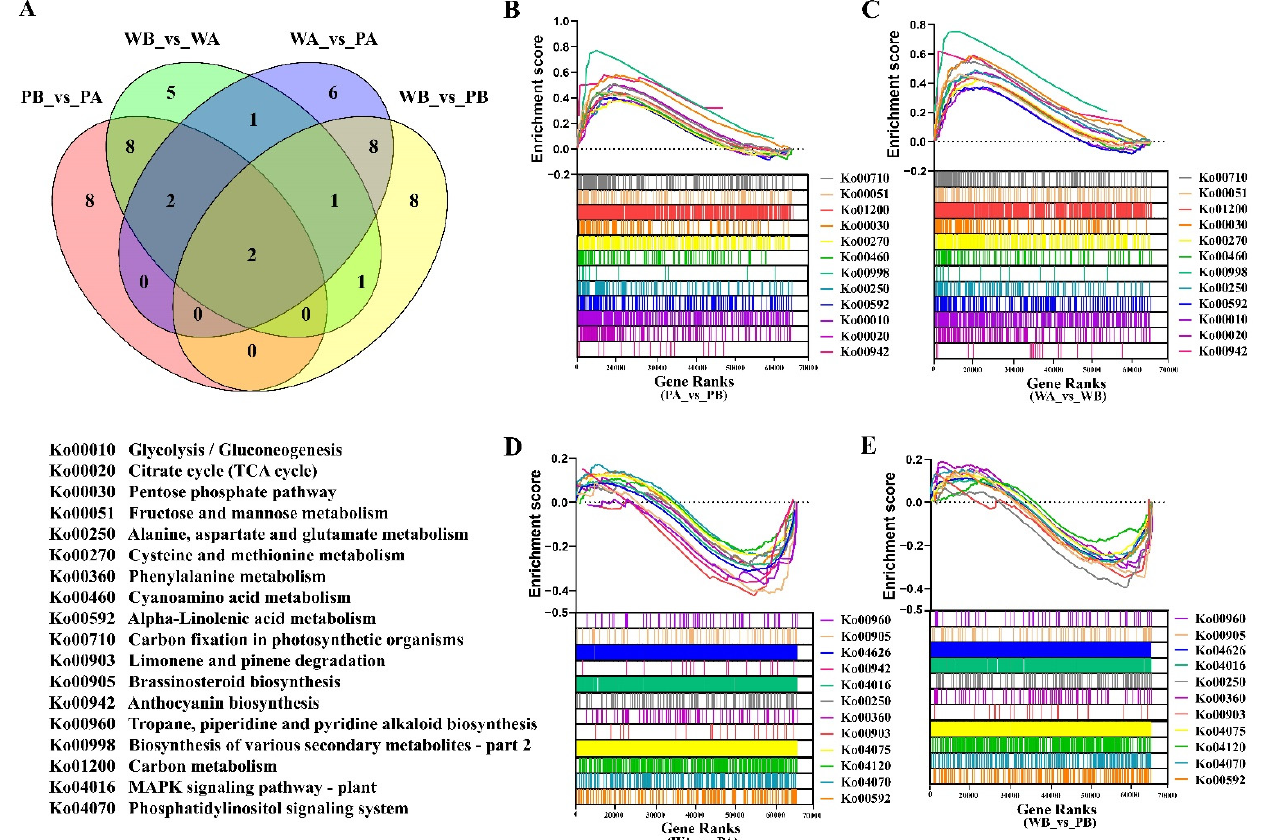
Figure 5. Gene set enrichment analysis (GSEA) was performed in four different comparison groups. ( A ) Venn diagram shows the distribution of the top20 enriched gene sets from four comparison groups (PA_vs_PB, WA_vs_WB, WA_vs_PA, and WB_vs_PB). ( B , C ) Represents the overlapping enriched gene sets from GSEA, comparing spot with non-spot of petals of PF or X74 (PA_vs_PB and WA_vs_WB). ( D , E ) Represents the overlapping enriched gene sets from GSEA comparing PF petals colored with X74 petals colorless regions of spot or non-spot. (WA_vs_PA and WB_vs_PB). PA, PB, WA, and WB represent the spot region and non-spot region of PF and X74 petals, respectively.